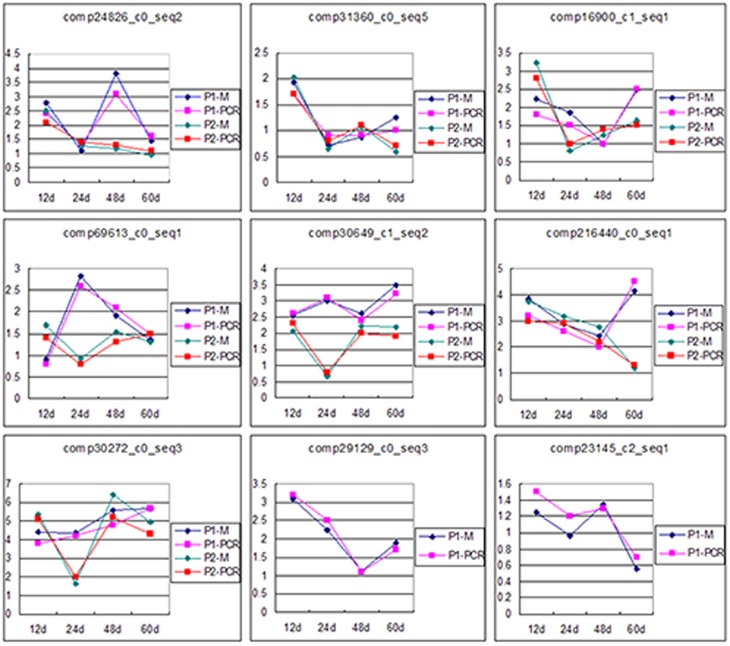
Expression profiles of nine randomly selected transcripts determined by qRT-PCR (-PCR) and microarray (-M).The x-axis indicates the duration of the Pi-deficiency stress, and the y-axis indicates the signal ratio. The conditions of P1 and P2 are described in the Materials and methods.